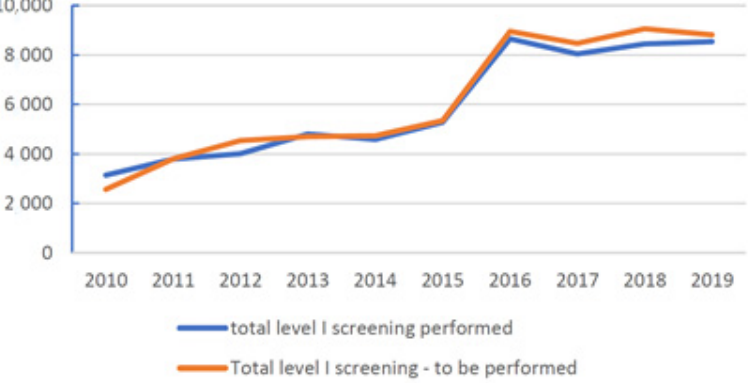
Figure 2. Trend of level 1 screenings carried out from 2010 to 2019.